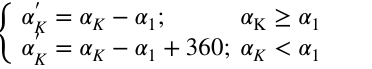
Fig. 9 Relative direction ( α with respect to direction α